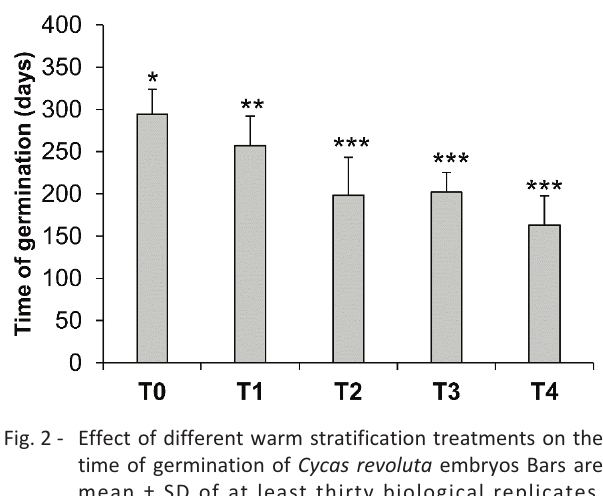
Fig. 2 ­ Effect of different warm stratification treatments on the time of germination of Cycas revoluta embryos Bars are mean ± SD of at least thirty biological replicates. Asterisks indicate statistical difference according to Tukey test